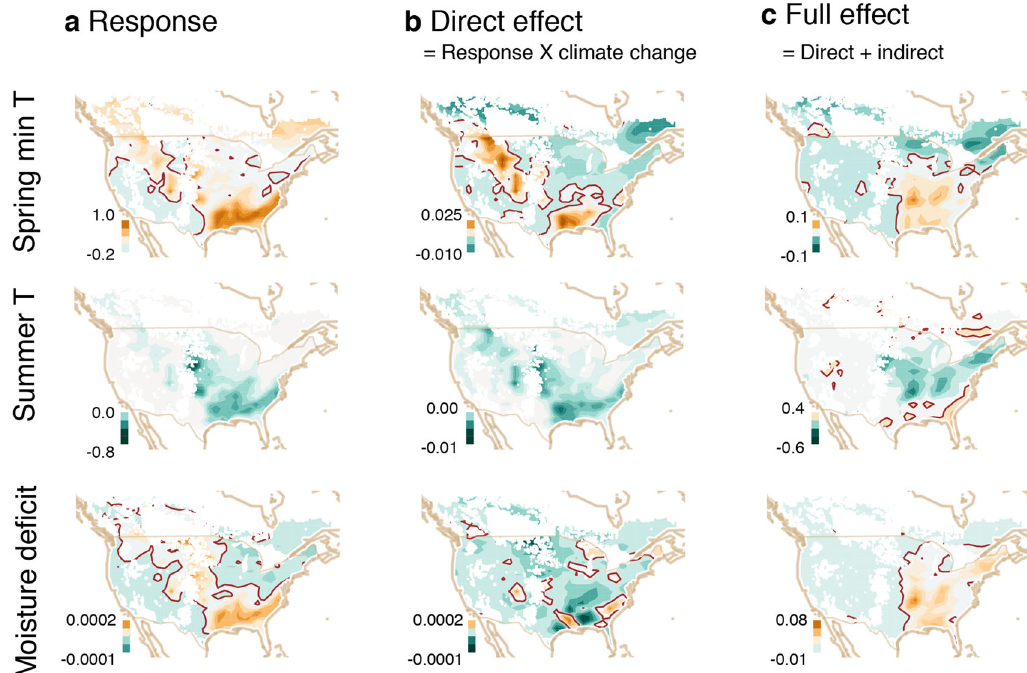
Fig. 4 Continent-wide causes for fecundity trends. Shaded contours are green (decreasing) to brown (increasing). Responses to climate variables ( ∂ f / ∂ C ) in a are multiplied by climate change (×d C /d t ) in Fig. 2a to give the direct effect ( ∂ f / ∂ C × d C /d t ) in panel ( b ) ( fi rst term of Eq. (1)). The direct effect in b is added to the indirect effect that comes through tree growth (terms 2 and 3 of Eq. (1)) to give the full effect in panel ( c ). Units are proportionate change in fecundity per °C or per mm[-month] moisture de fi cit in panel ( a ) and per year in panels ( b , c ). White areas lack inventory plots. The brown contour indicates zero.